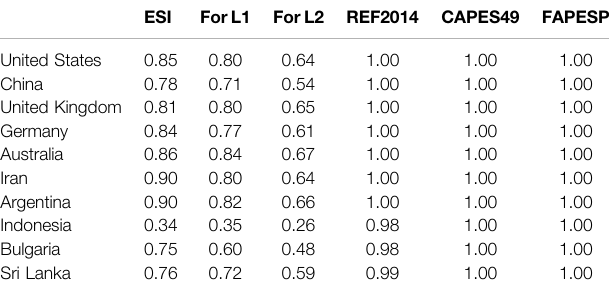
TABLE 3 | The ratio between numbers of papers assigned to the ten countries listed in Table 1 via the Web of Science journal-based disciplinary category scheme and six other categorical schema used in Clarivate InCites (schema identi fi ed in Note). The variations in the proportion of the literature that is covered will affect both the numerator and denominator citation counts in any subsequent normalization calculation of citation impact (see Figure 3